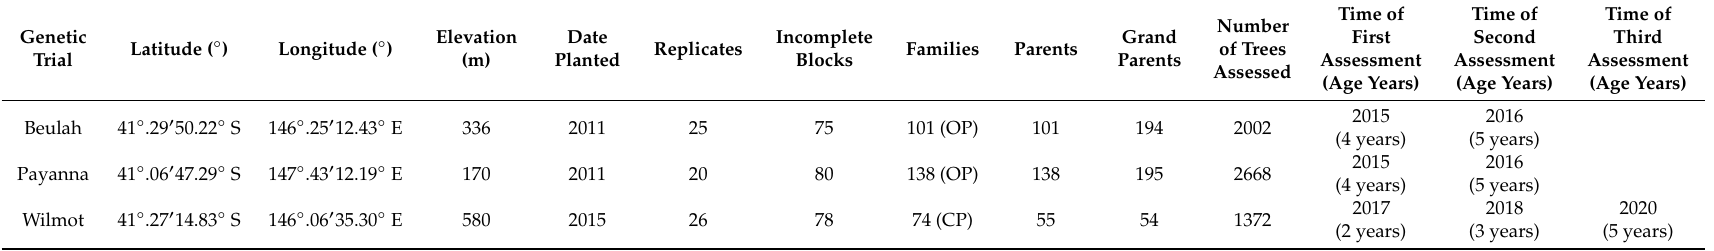
Table 1. Details of the three Pinus radiata genetic trials used for the study indicating the location and date of planting as well as the trial design, pedigree information, and assessment information. All trials were replicated in a randomized incomplete block design, with open-pollinated (OP) or cross-pollinated (CP) families represented as single tree plots within each block. For each trial, the number of replicates and incomplete blocks as well as the families, parents, grandparents, and total number of trees are indicated. The total number of trees denotes the trees that were alive at the time of assessment. Selected traits (see results) were measured multiple times and the age at which the assessments were performed is